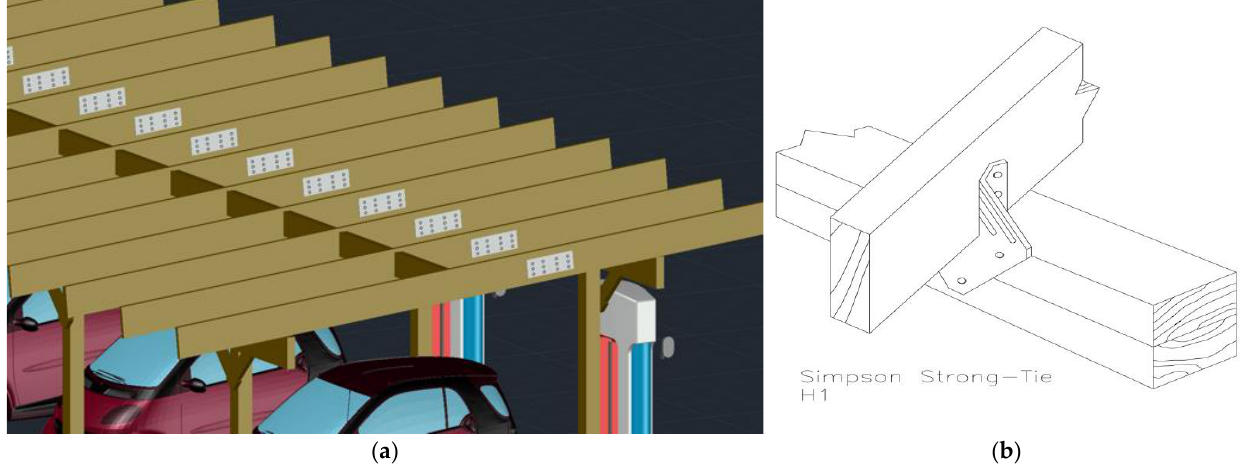
Figure 3. Single Span System ( a ) 2 × 10 joists installed along the beams, spaced 1 m apart, connected with splice joints, and braced with 2 × 10 braces, and ( b ) joist to beam installation using H1 hurricane ties.